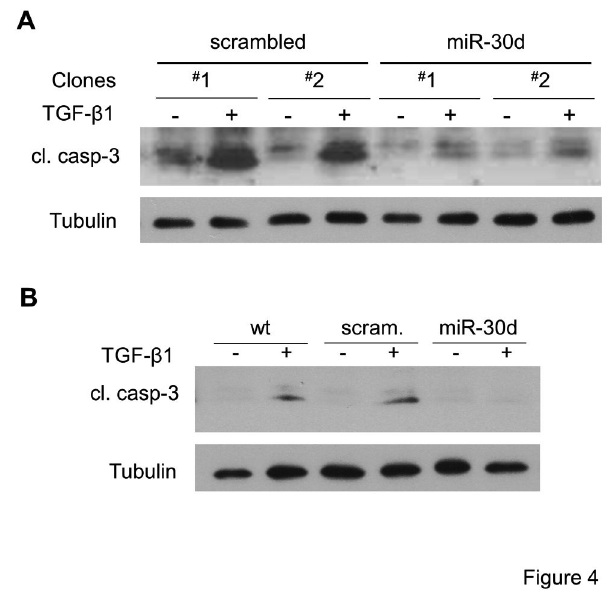
Figure 4. Lentiviral expression of miR-30d prevents TGF- β-induced caspase-3 activation. Immunoblots